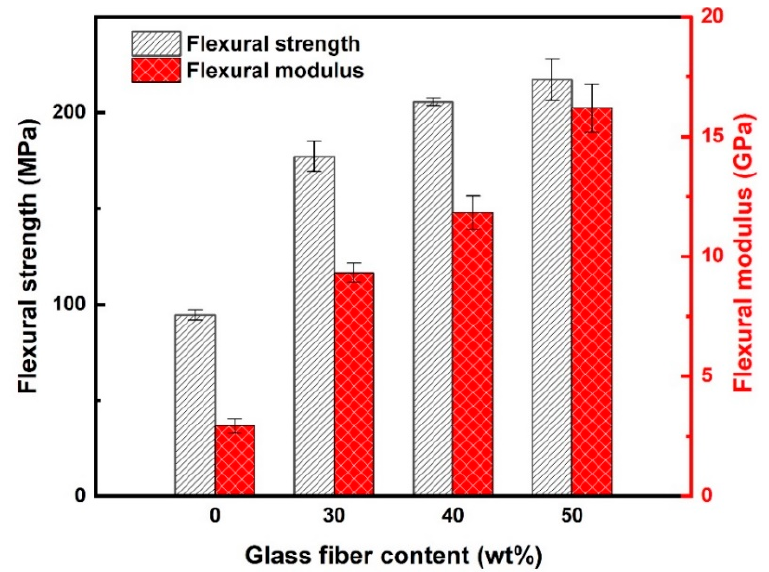
Figure 4. Effect of GF content on flexural strength and modulus of GF/mPPO composites.